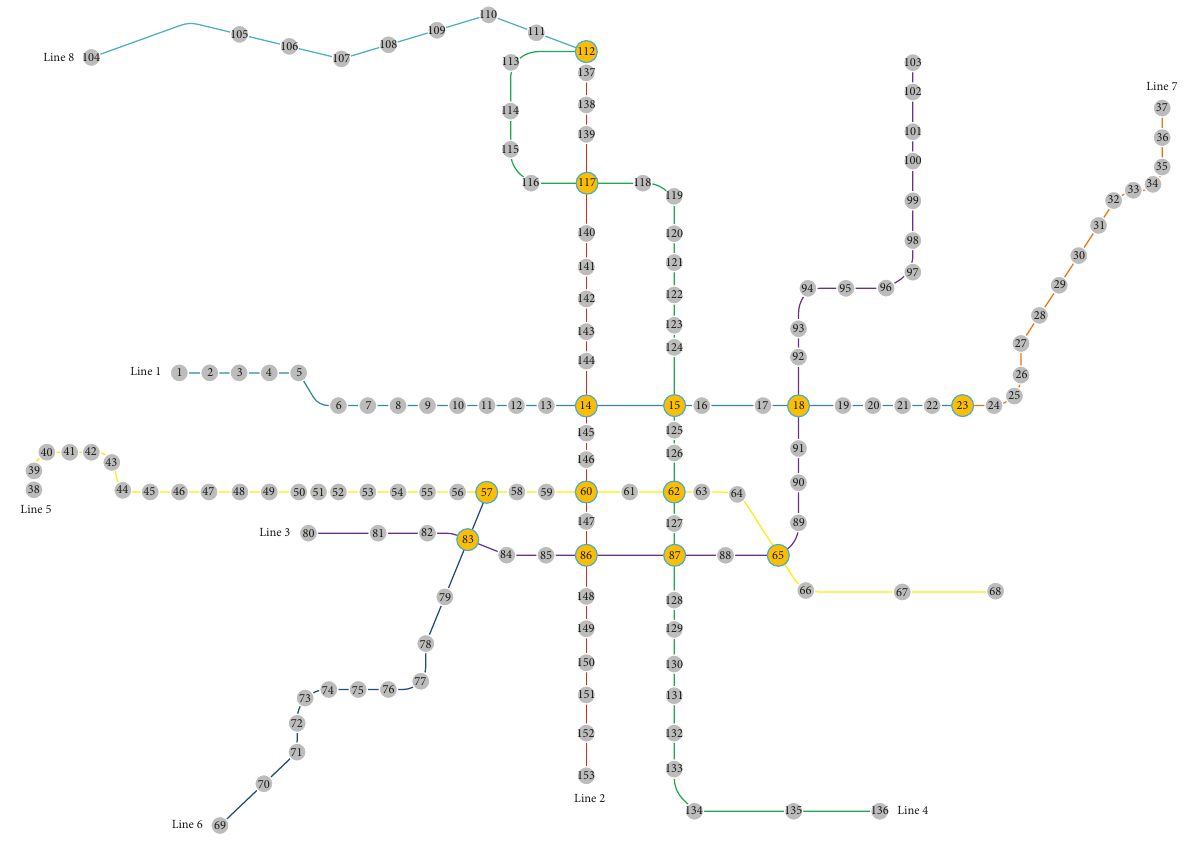
Figure 7: Map of the Xi’an metro